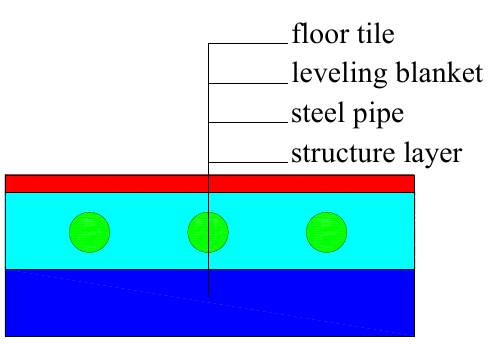
Figure 9. Schematic of the radiant floor.